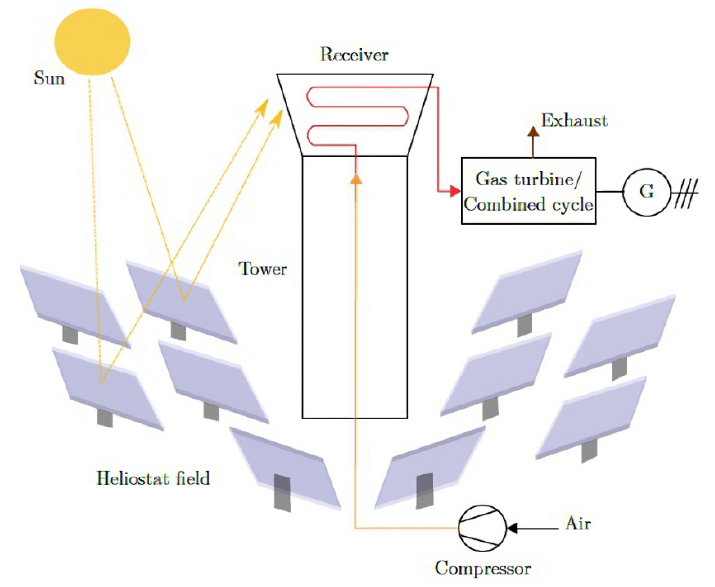
Figure 1. Central receiver solar power plant with direct solar heating.